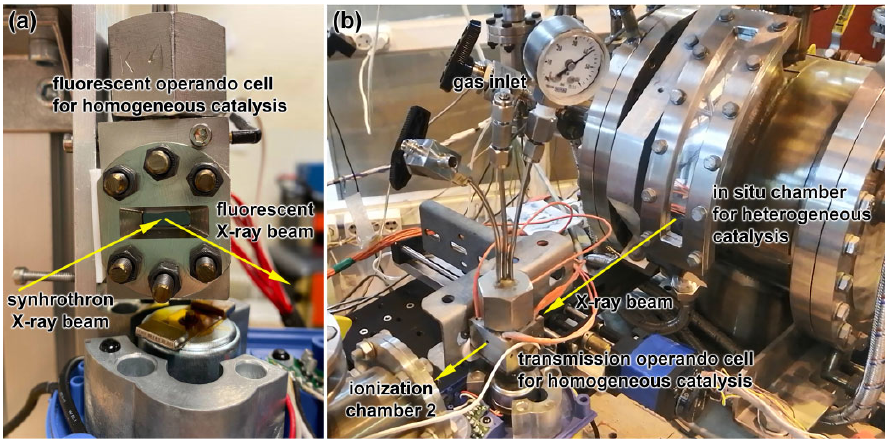
Figure 3. Photograph of the fluorescent ( a ) and transmission ( b ) cells during experiments at the